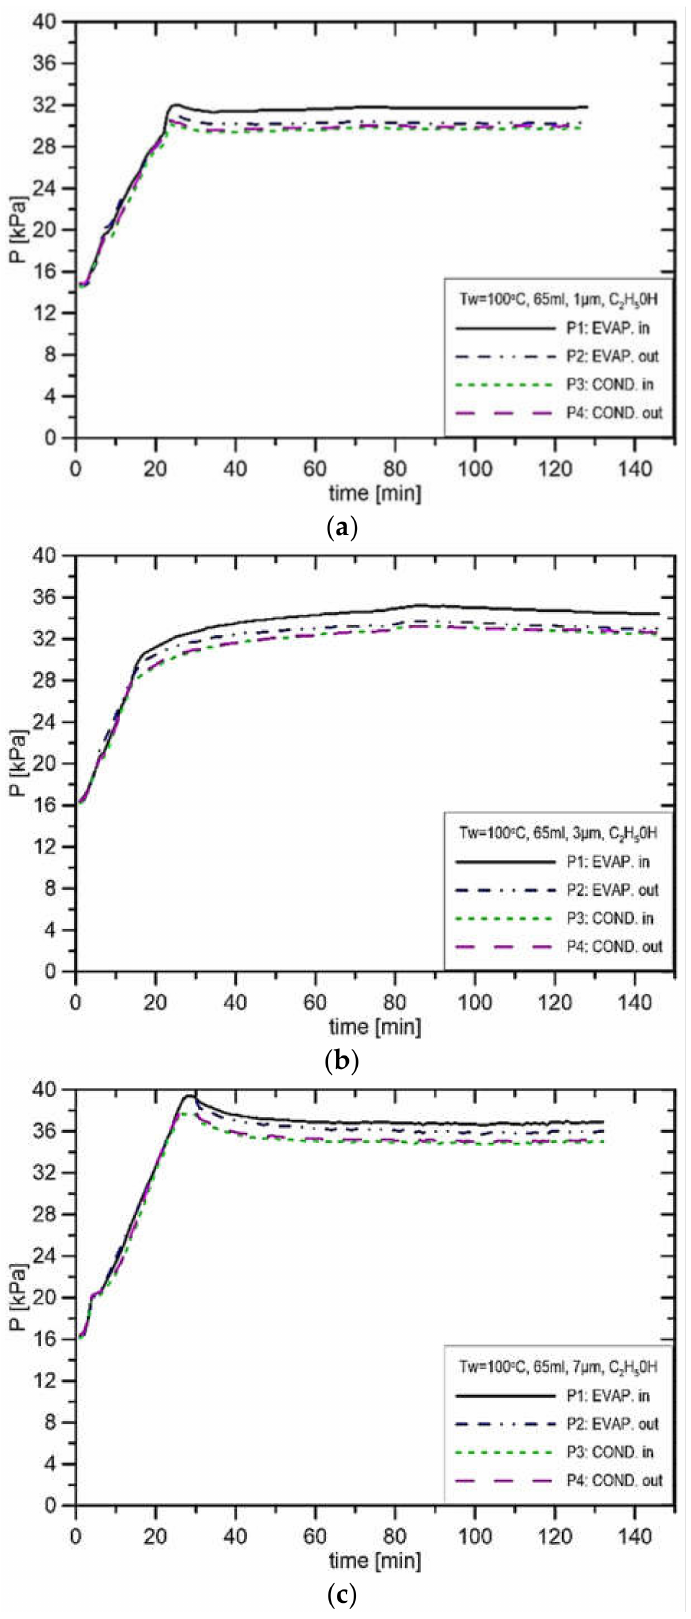
Figure 14. Distribution of pressure in function of time when using ethanol, charge volume 65